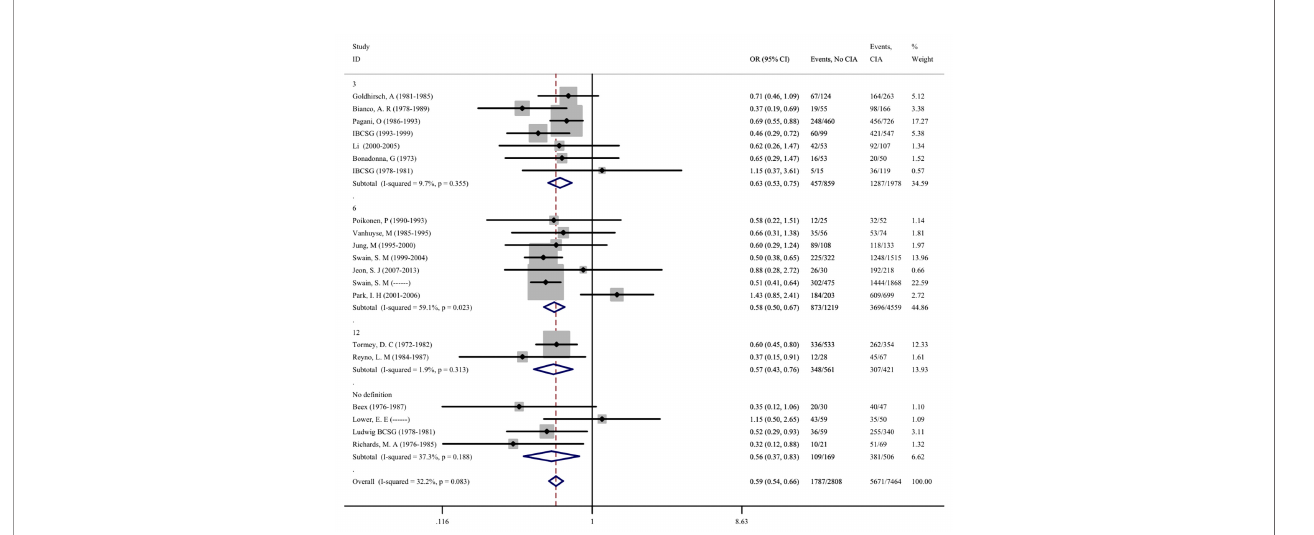
FIGURE 5 | No CIA versus CIA on DFS in premenopausal breast cancer